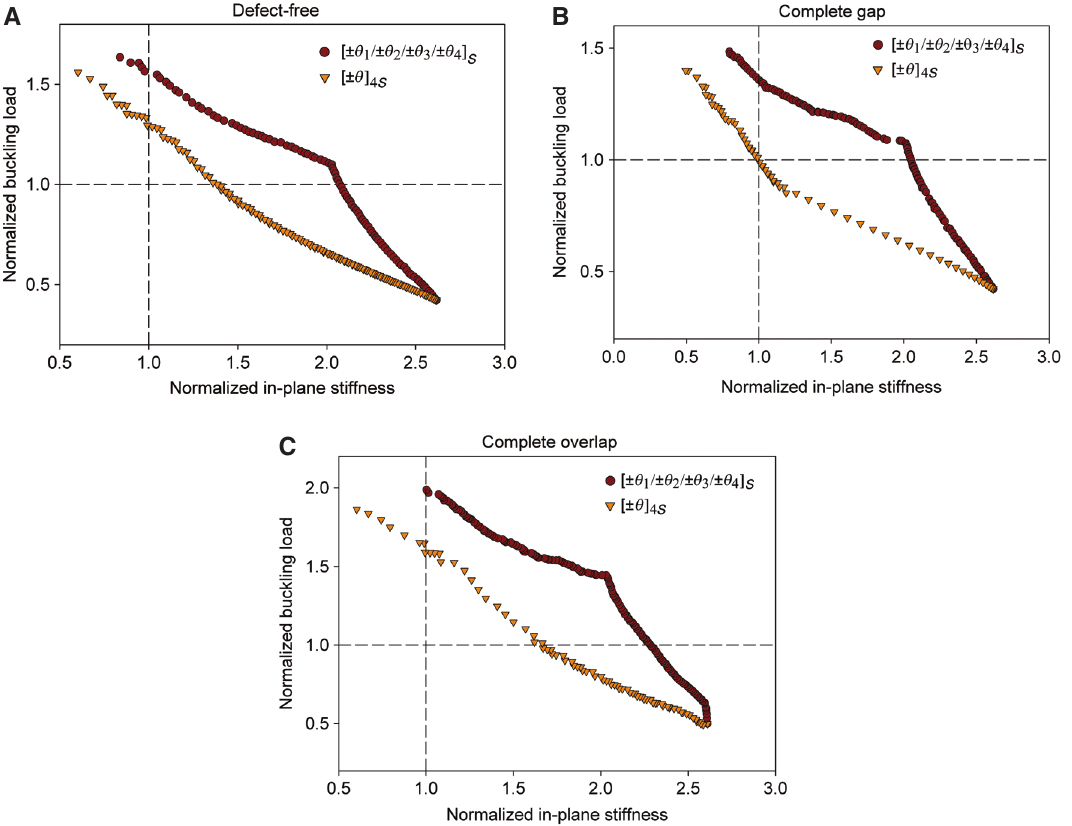
and [ ± θ ( x )/ ± θ ( x )/ ± θ ( x )/ ± 4 s 1 2 3